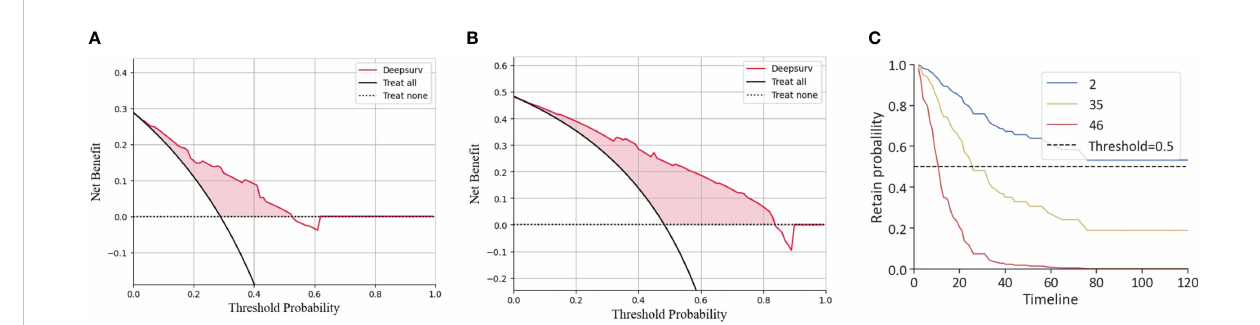
FIGURE 4 DCA of the DeepSurv model and the individual postoperative prognostic prediction. The 1-year (B) and 2-year (C) DCA of the DeepSurv model. (C) The estimated prognosis of patients in the training cohort. The blue line represents patient 2, the yellow line represents patient 35, and the red line represents patient 46. DCA, decision curve analysis.